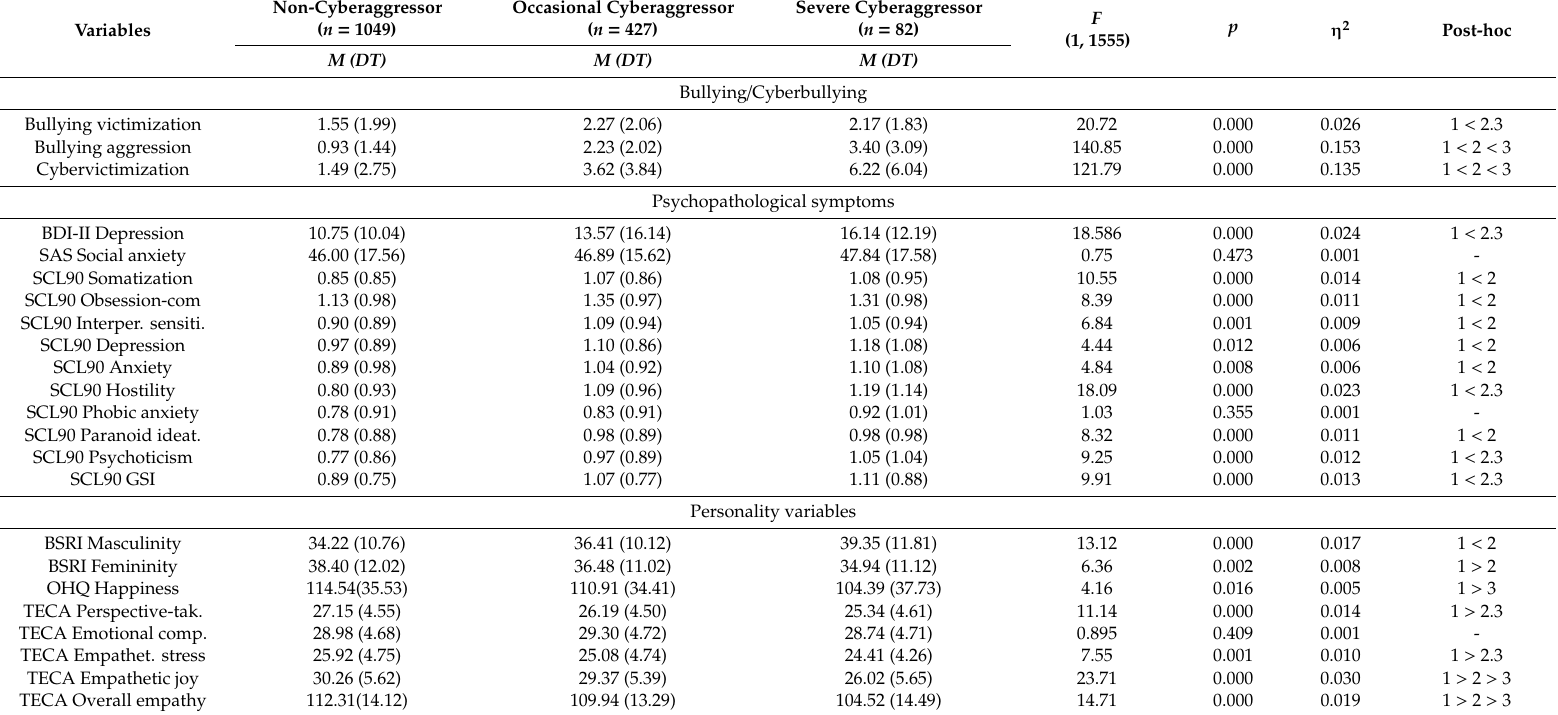
Table 2. Means and standard deviations in all the variables of the three profiles (non-cyberaggressor, occasional, severe cyberaggressor), results of the analyses of variance as a function of the profile, e ff ect size ( η 2 ), and post hoc group comparison